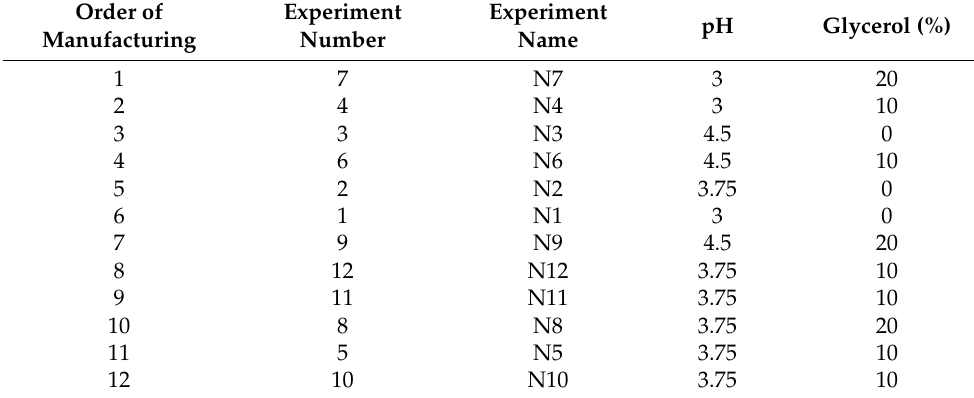
Table 4. Design of experiments for Naloxone 1 mg/mL. Name and order of experiments, pH to be set, and the amount of solubilizer (%). N5, N10–12 are replicates. The amount of sodium benzoate was 0.5%.